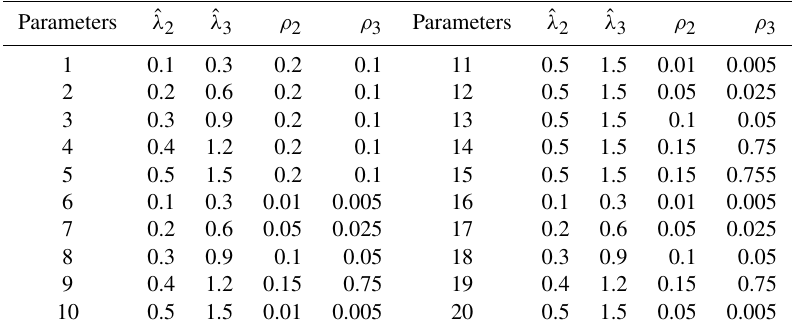
Table 1. The setting of the system control parameters.